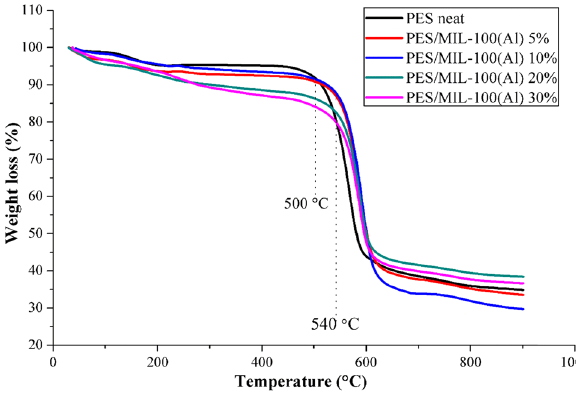
Figure 10: Thermogram of di ff erent percentage additions of MIL - 100 ( Al ) to PES.